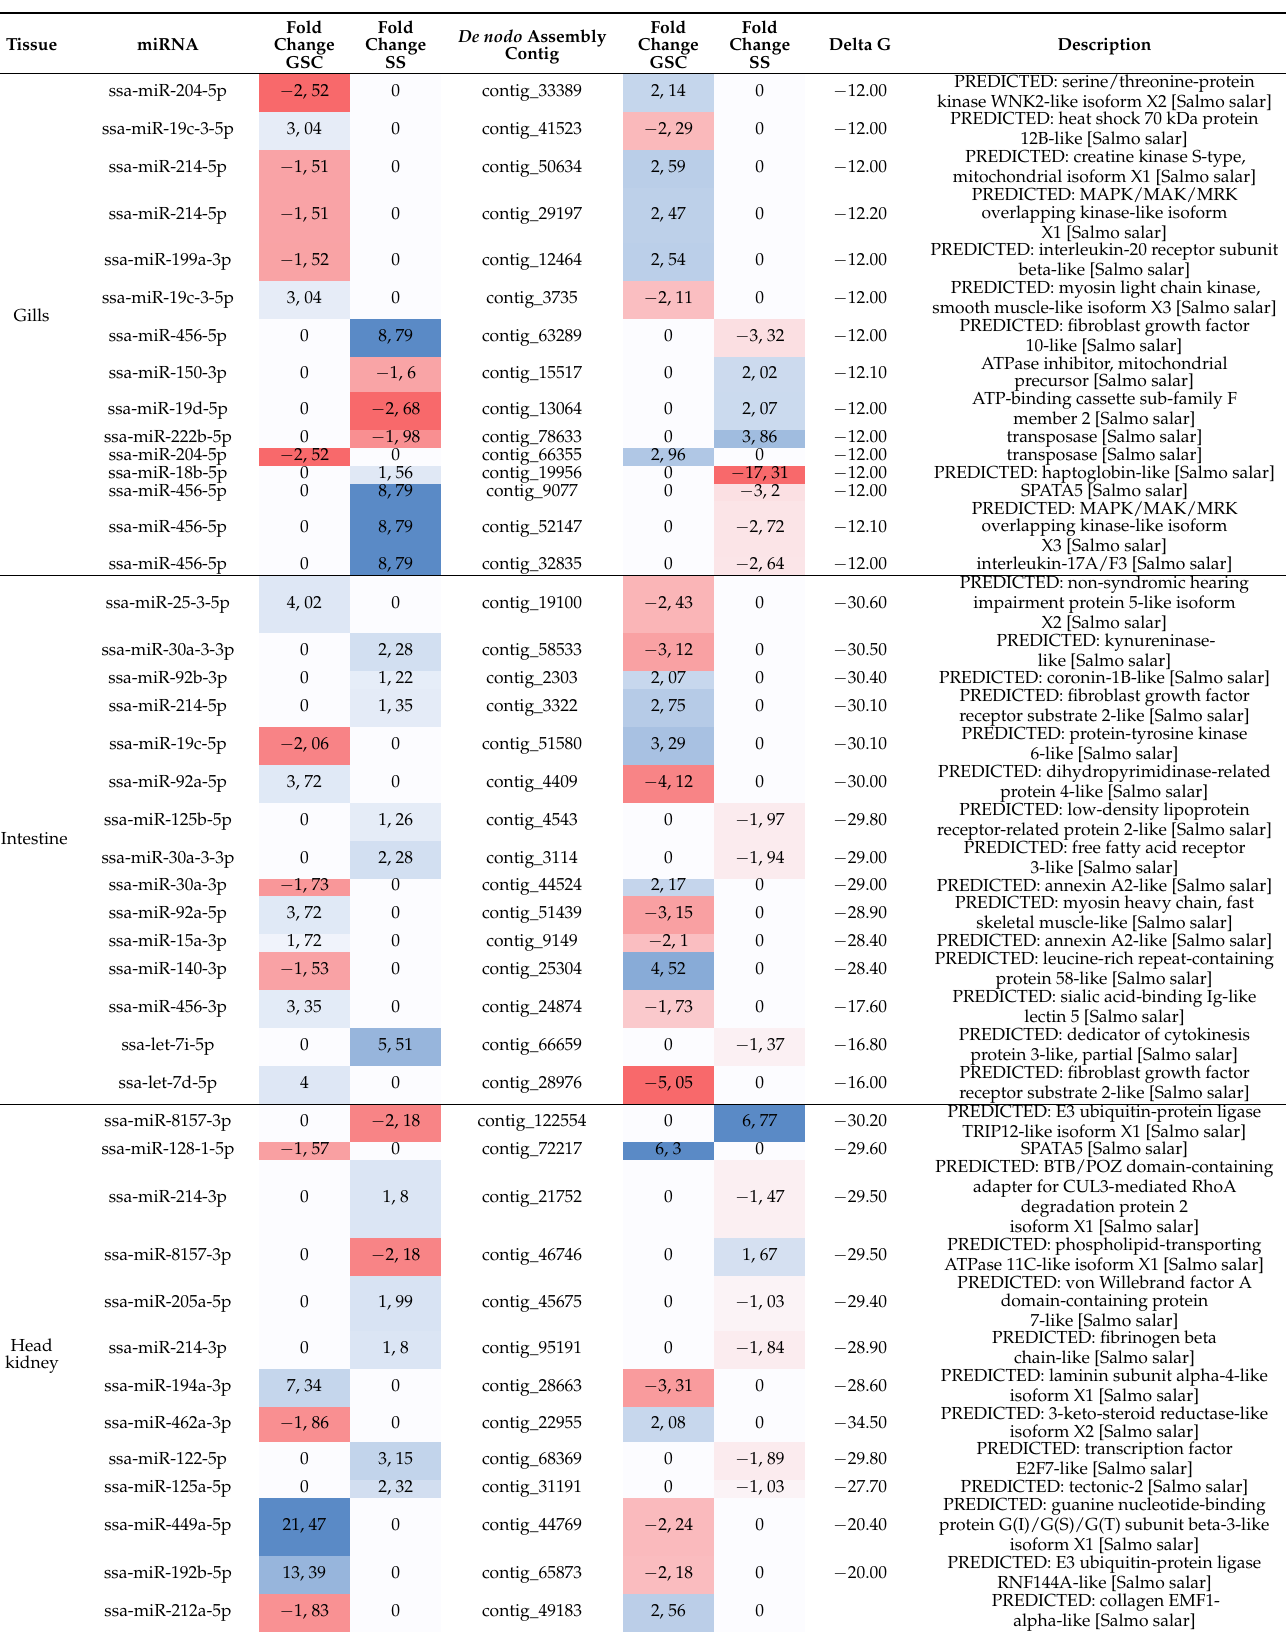
Table 2. Expression modulation of miRNAs and their putative target genes in Atlantic salmon exposed to GSC and